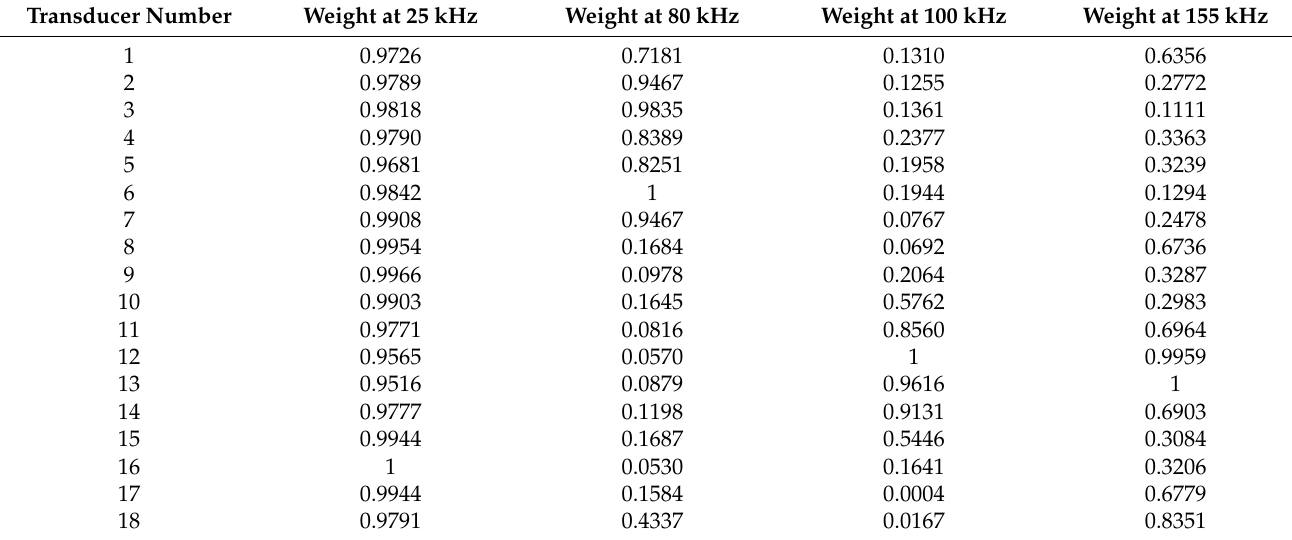
Table 1. Normalized weights.